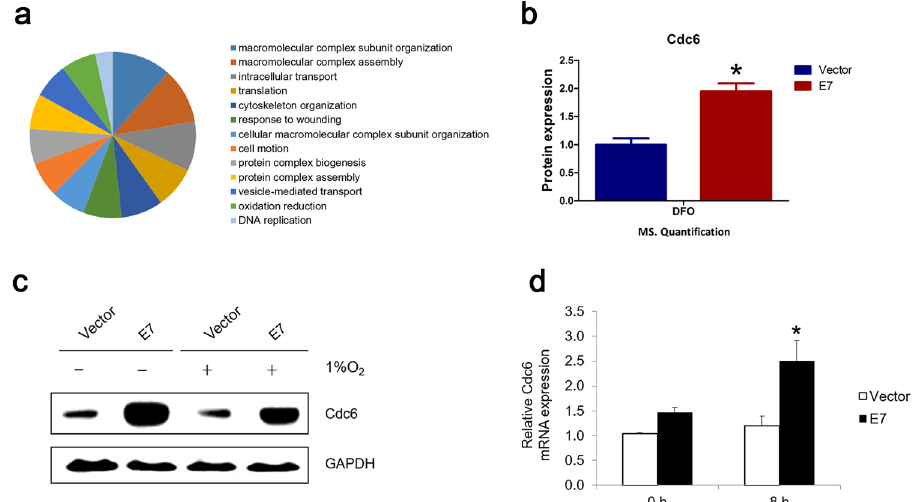
Figure 4. Label-free mass spectrometry quantification of RPE1 vector and E7 expressing cells under hypoxia. ( a ) RPE1 vector and E7 expressing cells treated with 200 μ M DFO were prepared for mass spectrometry. Functional classification of differentially expressed proteins that were quantified by M.S. ( b ) Expression level of Cdc6 in vector and E7 expressing cells under hypoxia was determined by M.S. ( c ) Verification of Cdc6 steady-state level in vector and E7 expressing cells treated in hypoxic chamber at 1% oxygen by immunoblotting (original blots are presented in Supplementary Figure 3). ( d ) Verification of Cdc6 mRNA level in vector and E7 expressing cells treated with 200 μ M DFO by RT-qPCR. Error bars reflected the standard error of the mean. * P <